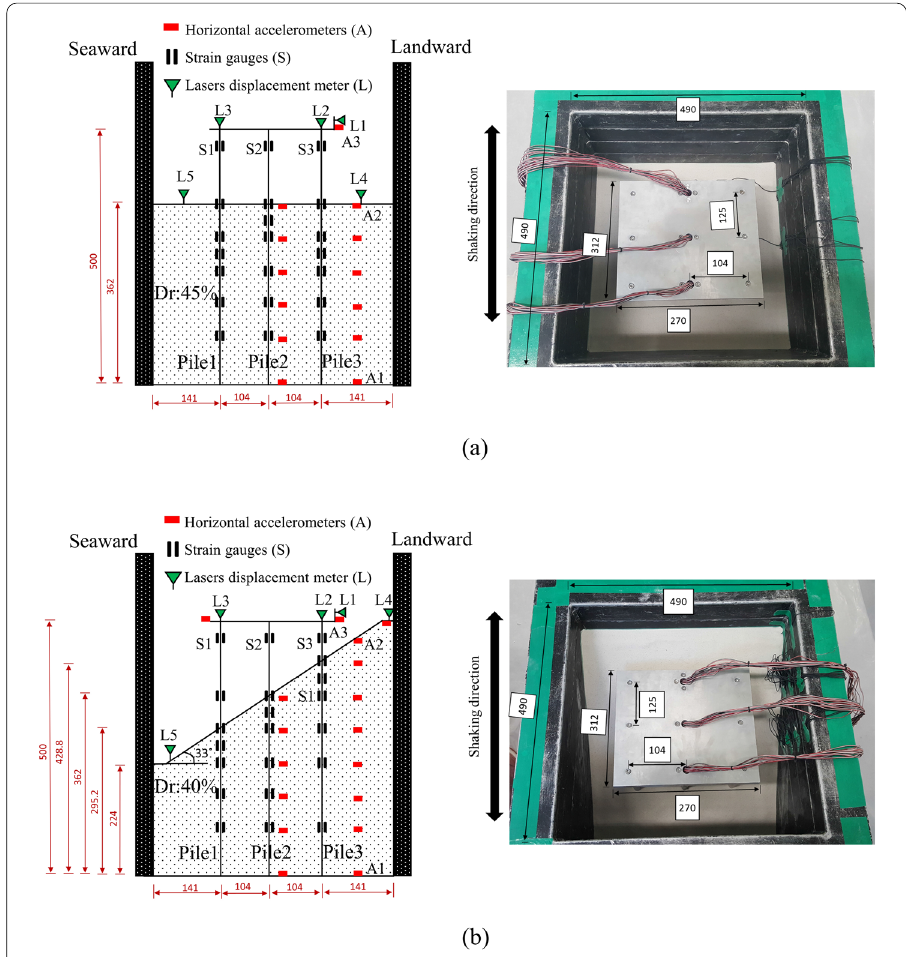
Fig. 5 Cross‑section and experimental models a HA45, b IA40 (unit: mm)